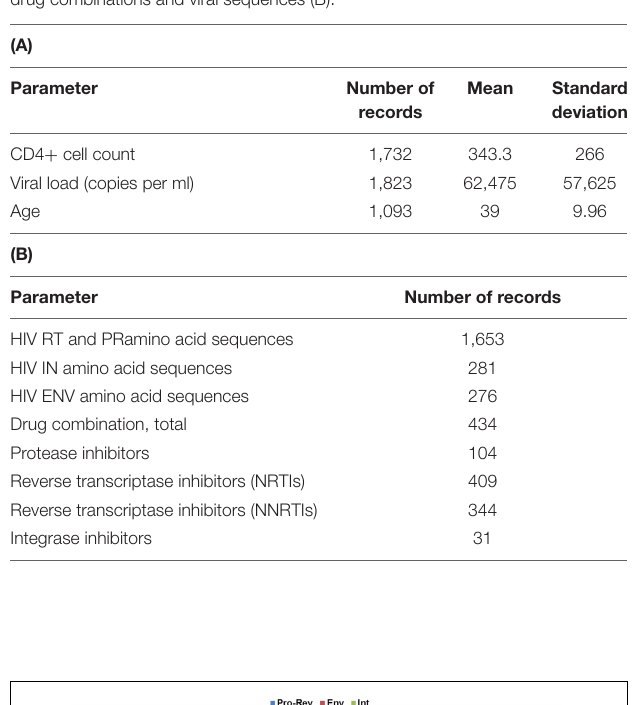
TABLE 1 | Database characteristics. Number of records and values for each quantitative parameter of the database (A); number of records containing data on drug combinations and viral sequences (B).